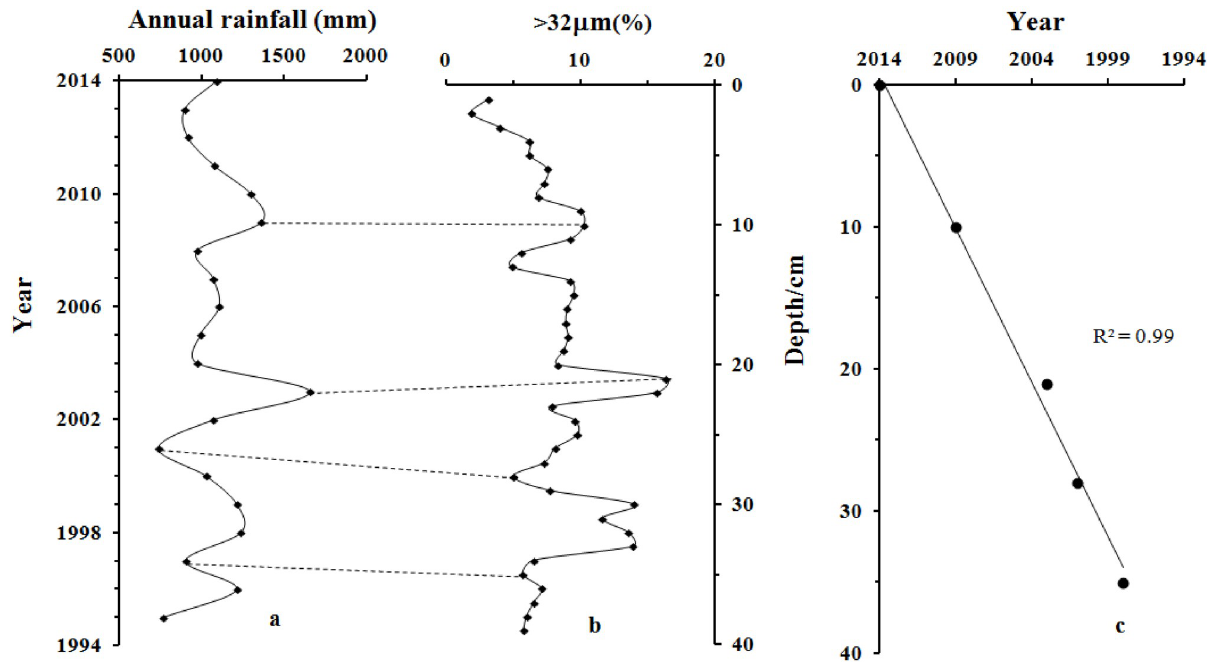
Fig 5. Variations in annual rainfall in Nanjing City (a), > 32 μm particle size concentration (%) of core QH1 (b), and the established age–depth model